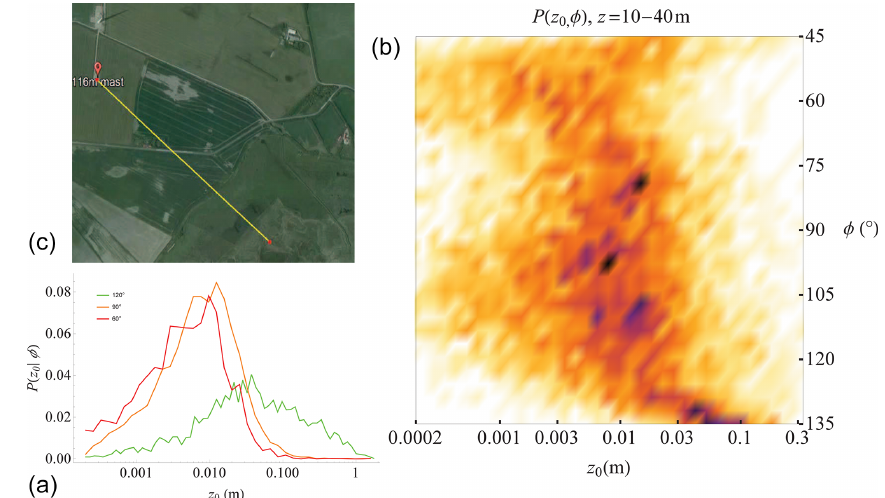
Figure 1. (a) Distribution of z 0 for homogeneous land sectors (30 ◦ wide) east of Høvsøre. (b) Joint distribution of z 0 and wind direction φ ; darker represents most common values, and white is no occurrence. Calculation follows Eq. (2), with z 1 = 10 and z 2 = 40m, and it is limited to neutral conditions ( | L | − 1 < 0 . 001m − 1 ). (c) Visual map east of site (red pointer; southern border of homogeneous zone at ∼ 130 ◦ denoted by yellow